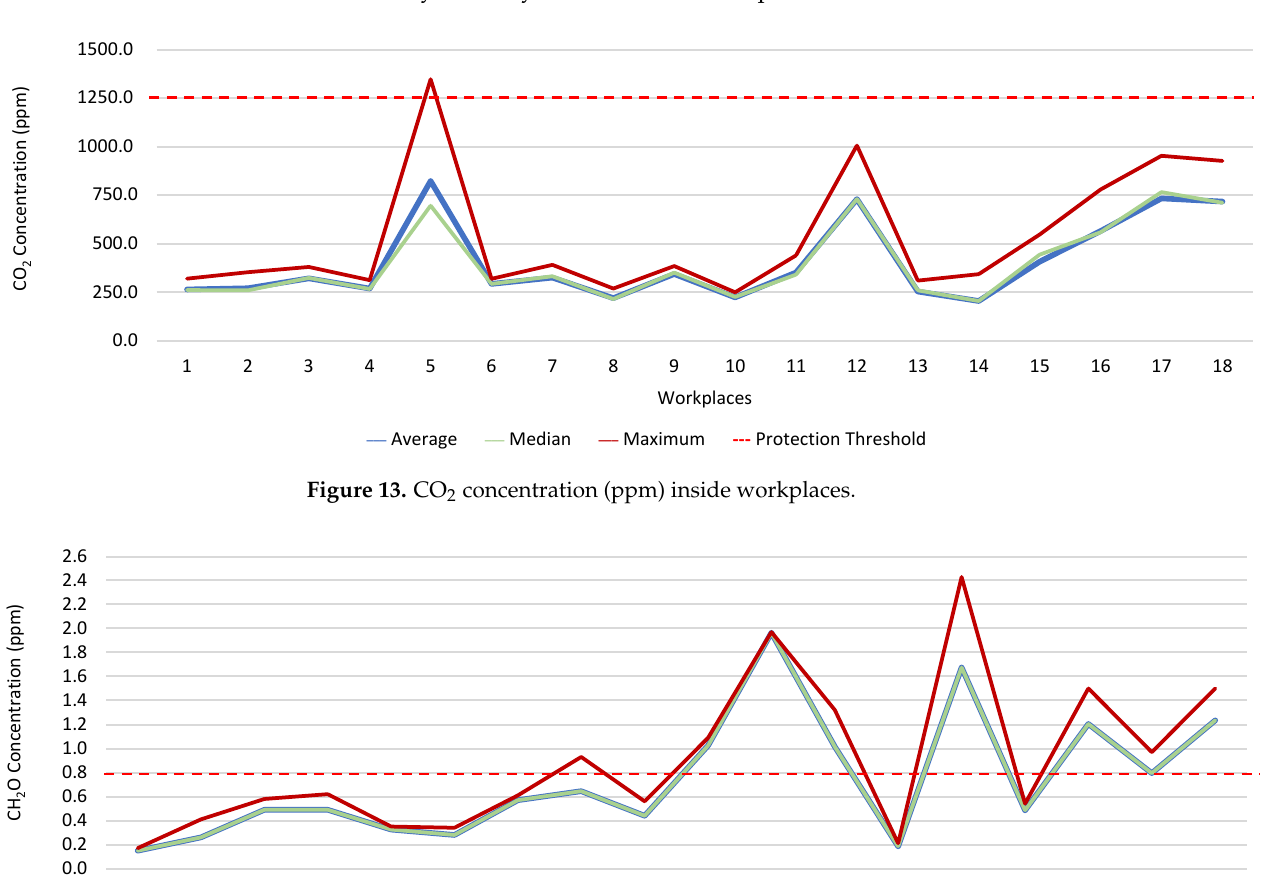
Figure 15. PM 2.5 concentration ( μ g·m − 3 ) inside workplaces. Figure 16. PM 10 concentration ( μ g·m − 3 ) inside workplaces.